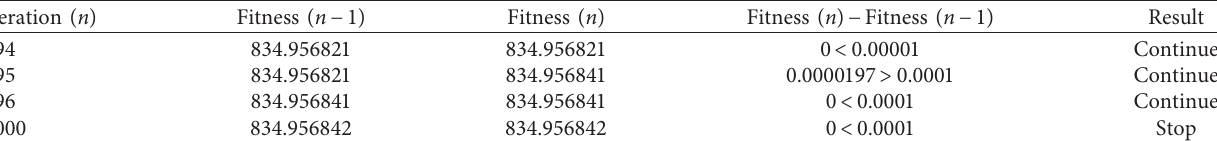
Table 3: Precision level and calculation termination in the 1000th iteration.